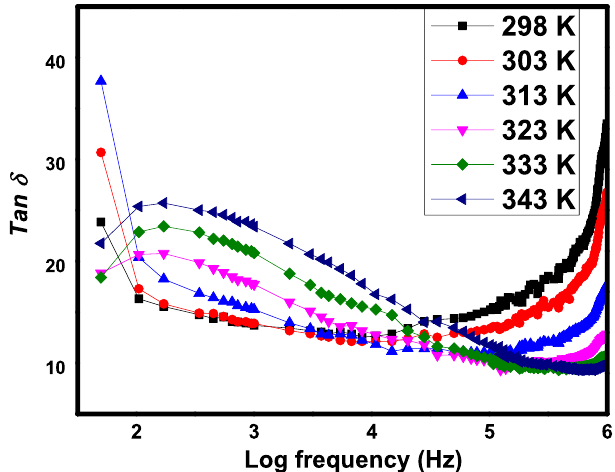
Figure 8. Tan δ of SrLaLiTe 1− x Mn x O 6 ( x = 0.08) at different